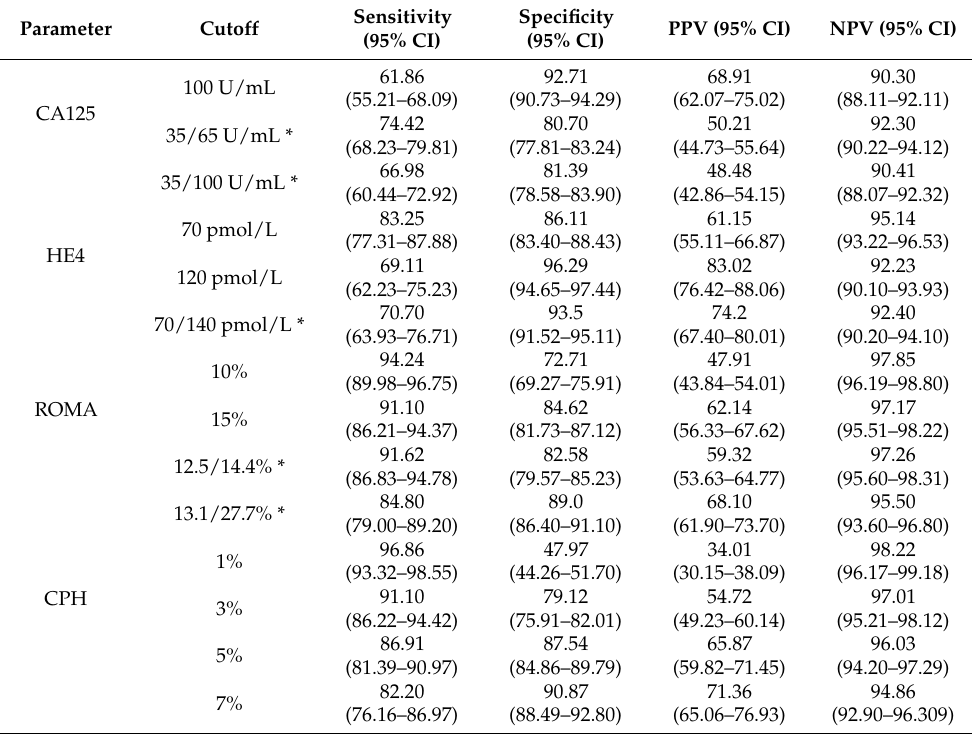
Table 3. Sensitivity, specificity, and predictive values of Ca125, He4, ROMA index and CPH-1 index at different cutoff